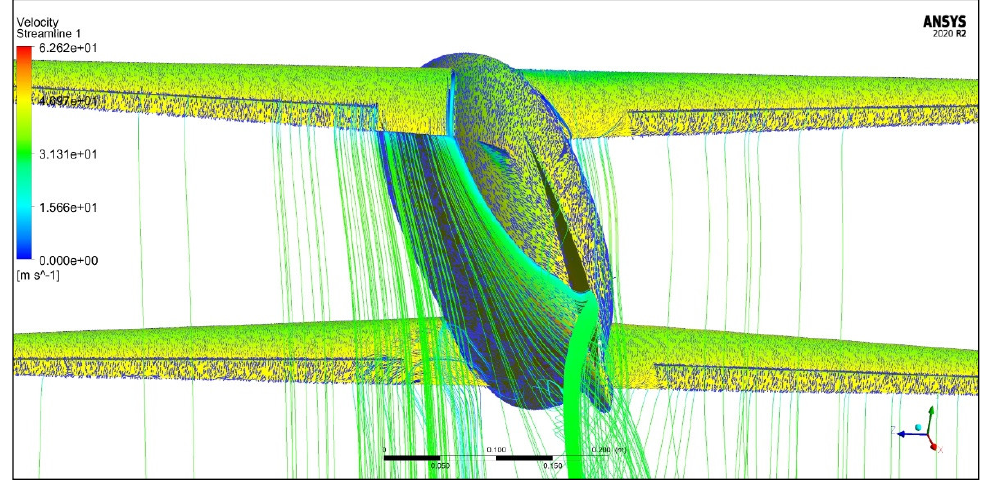
Figure 16. Velocity streamlines on model with LVG_1 and upper fin at β = 15° showing the fuselage sidewash effect on the upper fin.